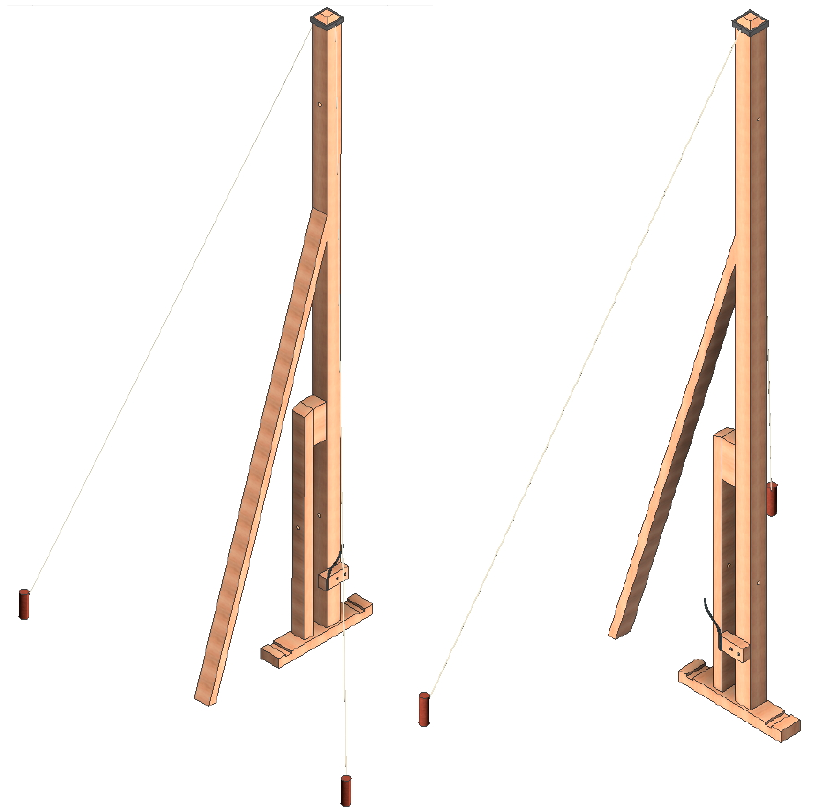
Figure 7. Mast frame (posterior and anterior view).